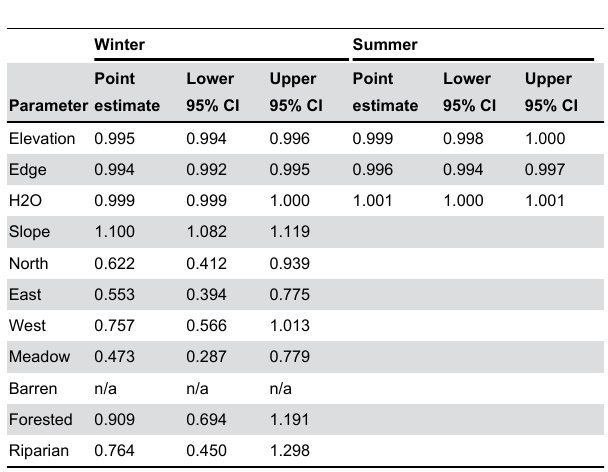
Table 5. Odds ratios for top ranked resource selection function model of seasonal kill sites by